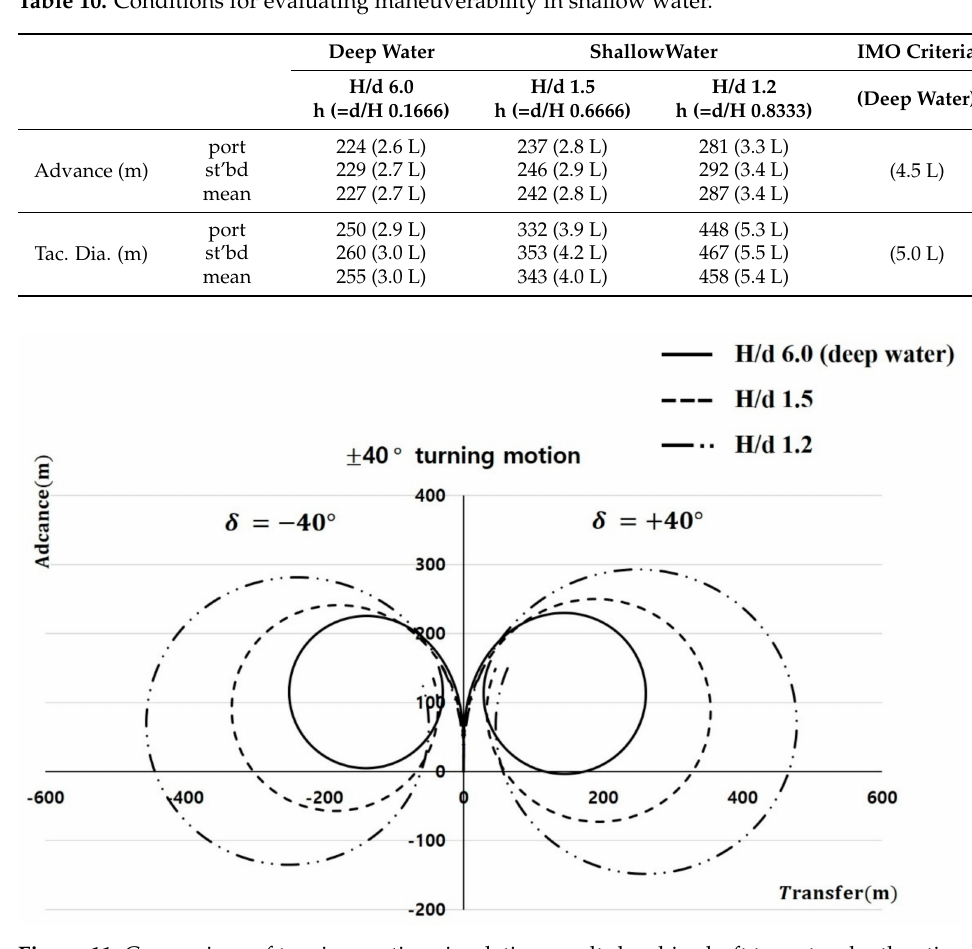
Figure 11. Comparison of turning motion simulation results by ship-draft to water-depth ratio.